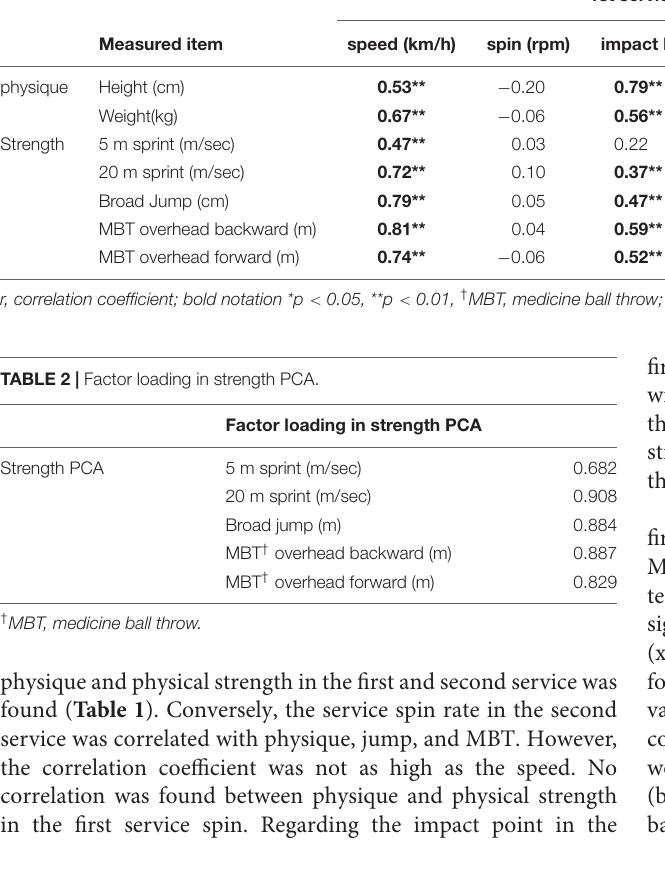
FIGURE 1 | Experimental set up for service performance test and service impact items (Koya et al., 2021). TABLE 1 | The correlation coefficient of physique and physical strength versus service performance. 1st service 2st